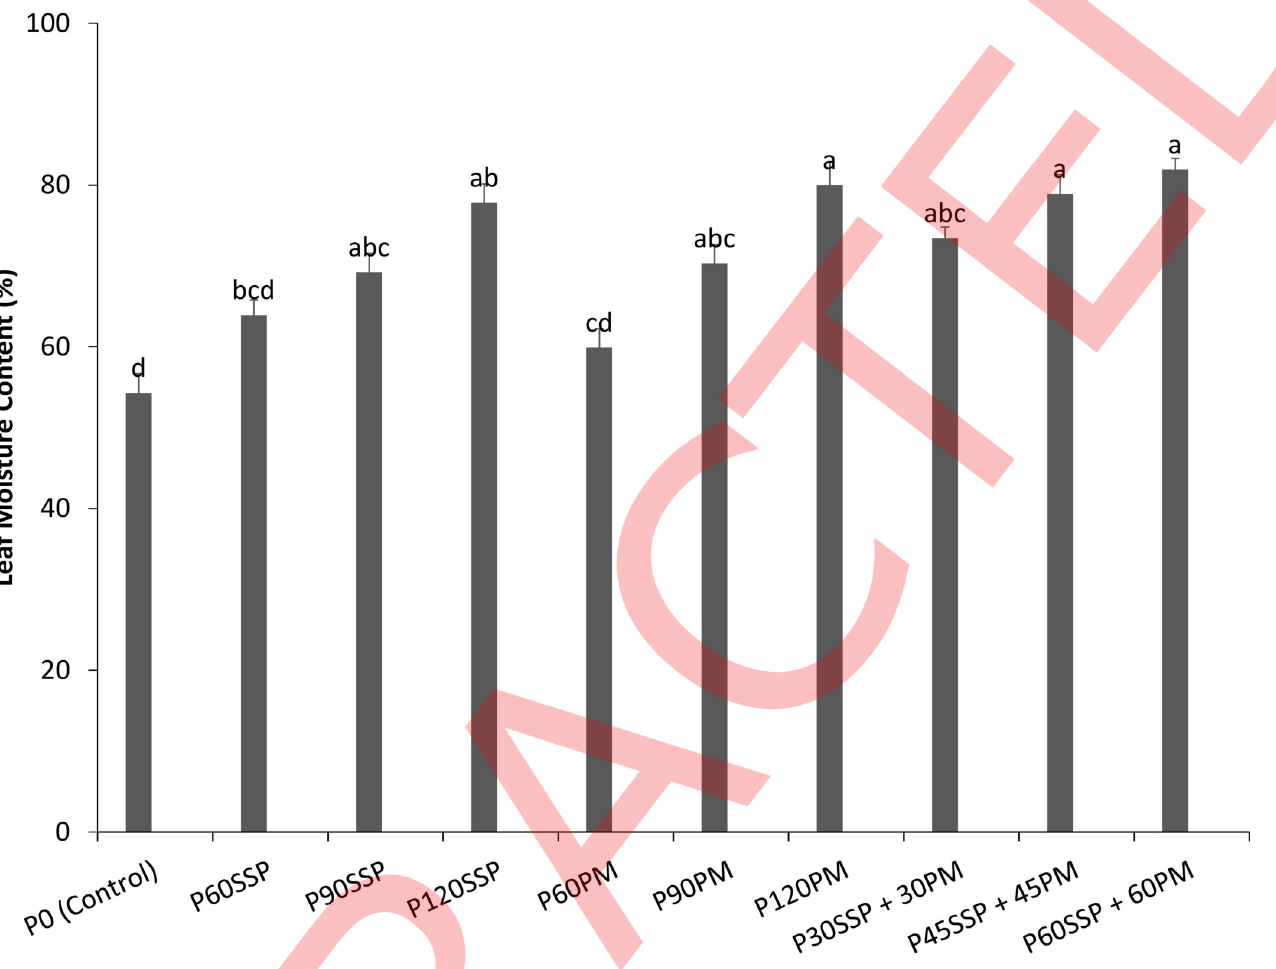
Fig 5. Effect of various organic and inorganic P nutrient sources on wheat leaf moisture content at heading stage.